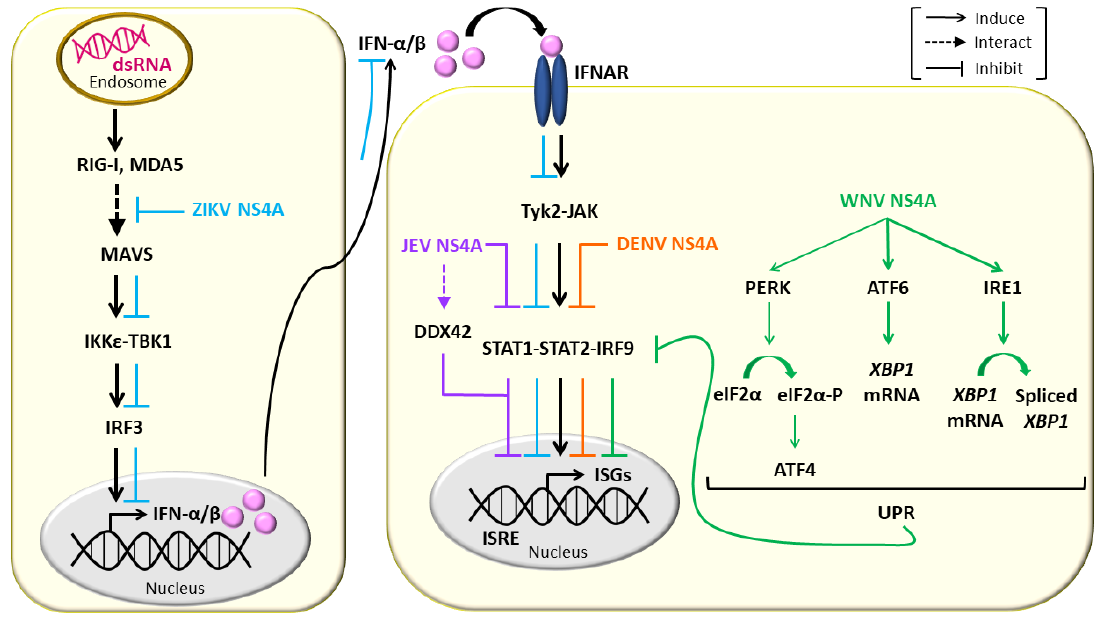
Figure 3. NS4As modulate the interferon response. NS4As manipulate RIG-I-like receptor signaling, DDX42 helicase, JAK/STAT signaling and the unfolded protein response (UPR) to counteract the interferon- α / β (IFN- α / β ) response.